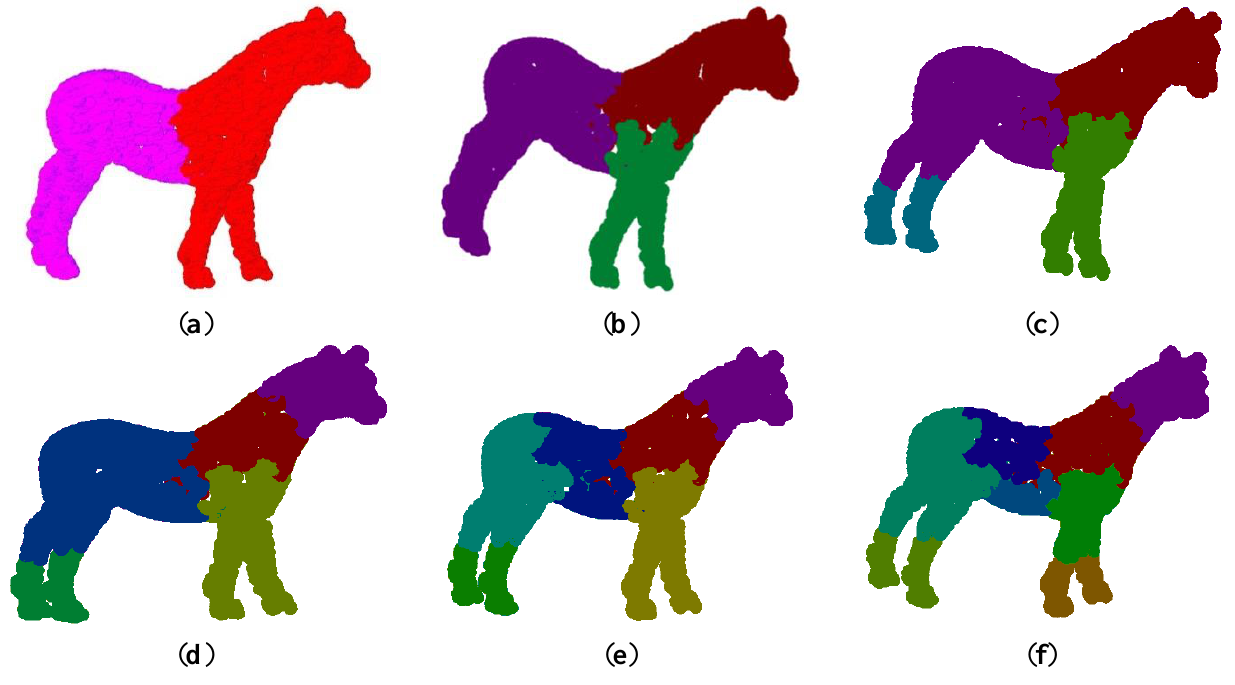
Figure 8 . 3D point cloud of the Horse ( a ) and its 3D Voronoi diagram ( b ).